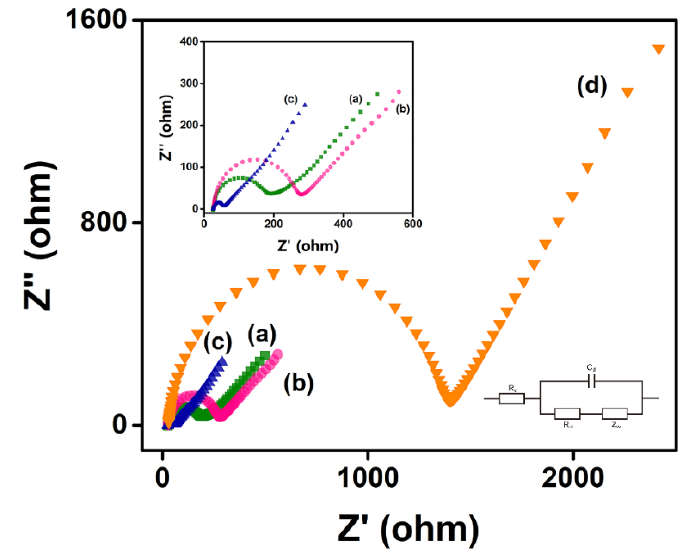
Figure 3. Nyquist plots of (a) AuSPE, (b) Chi/AuSPE, (c) Chi/MXene/AuSPE, (d) Chi/MXene/ Rs D2HGDH/AuSPE in 5 mM K 3 /K 4 Fe(CN) 6 redox probe containing 0.1 M KCl. Insert: Amplified Nyquist plot of (a) AuSPE, (b) Chi/AuSPE, (c) Chi/MXene/AuSPE.